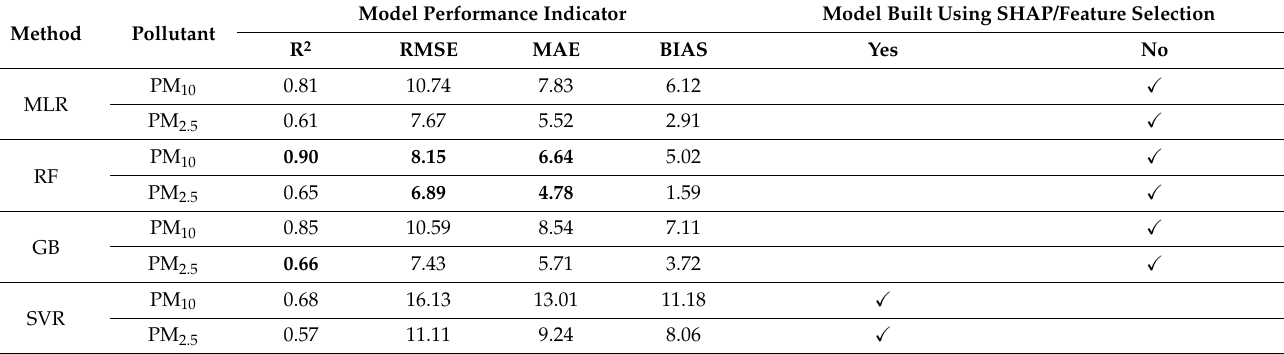
Table 3. Comparison of the MLR, RF, GB, and SVR models trained using 2013–2018 data and tested on 2020